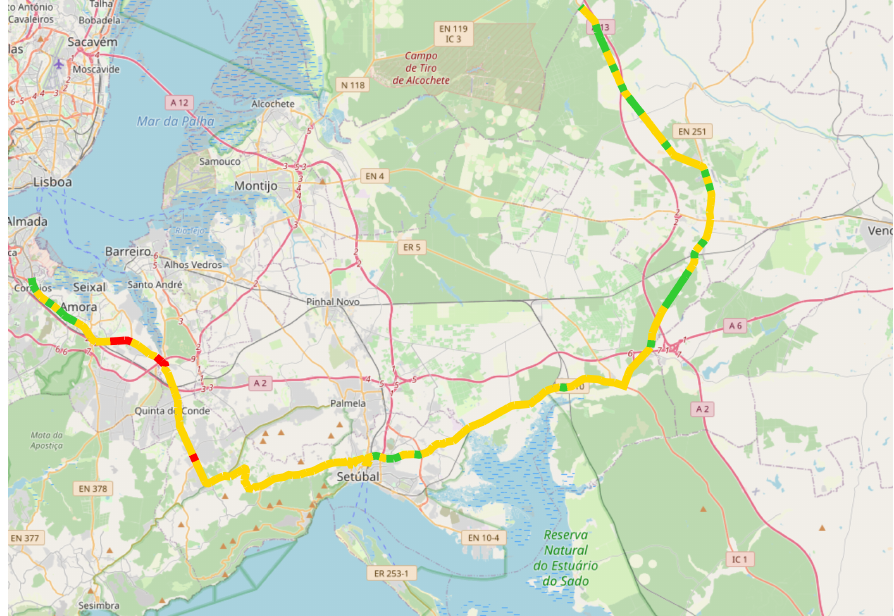
Figure 5. Digital application to support decision: prediction probability of an RTA in EN10 on a given time of the day by segments of 500 m. Red segments have a probability greater than 90%, yellow segments have a probability greater than the cut-off point and lesser than 90% and green segments have a probability lesser than the cut-off